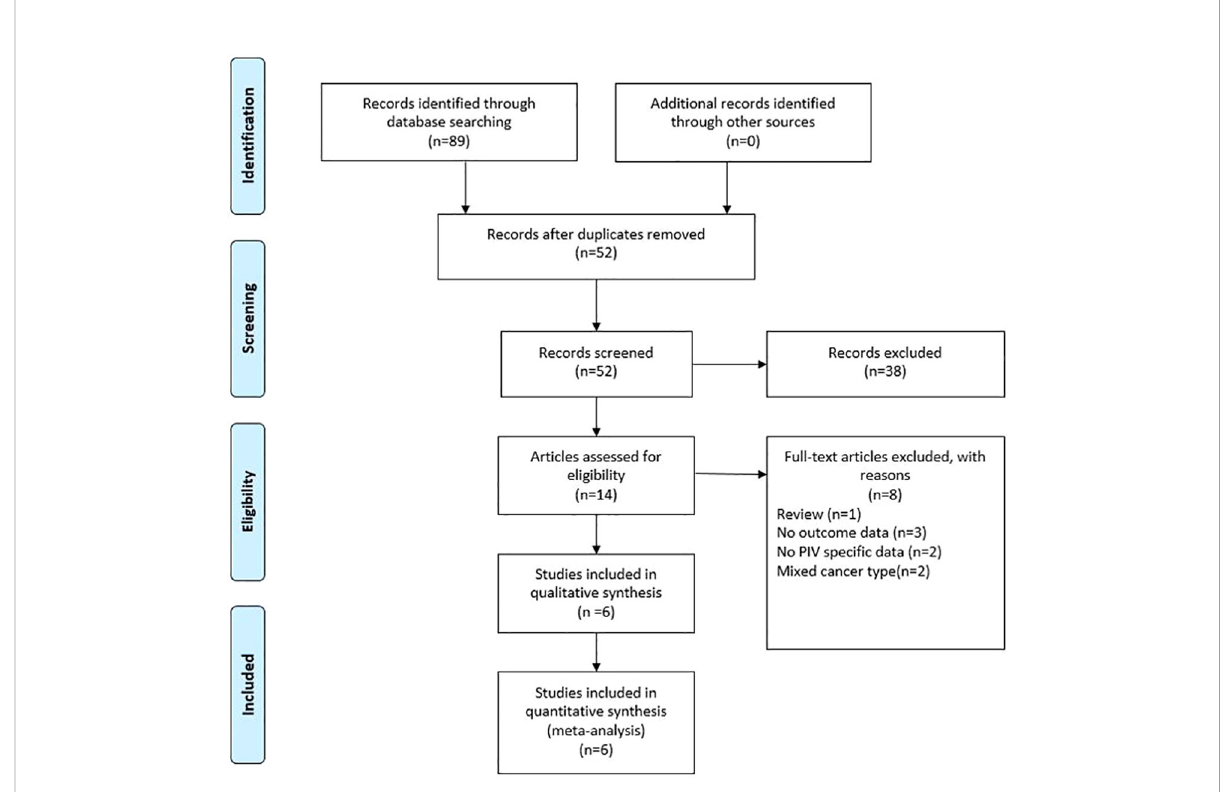
FIGURE 1 The PRISMA Flowchart of study selection.